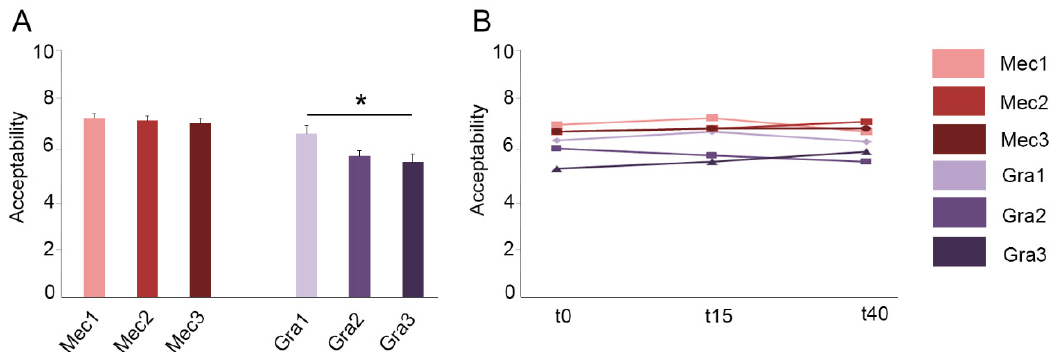
Figure 2. Acceptability test for all samples measured at time 0 ( A ) and evolution over a period of time ( B ). Samples indicate different concentrations of the active ingredients as shown in Table 1. Values are presented as mean ± SEM from at least eighteen independent measures. Kruskal-Wallis and Dunn’s multiple comparison post hoc test were used for statistical analysis. * p < 0.05.